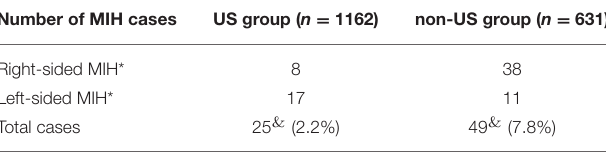
TABLE 3 | Cases of MIH based on the laterality of the initial inguinal